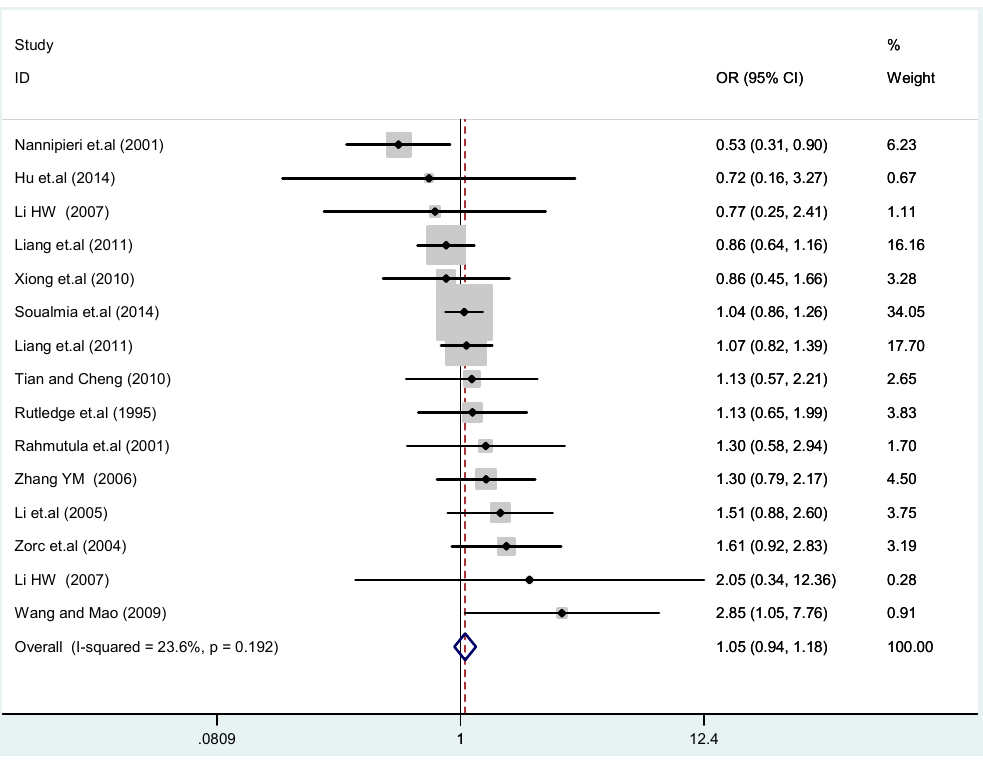
Figure 2. Forest plot of overall population of T2238C additive model (C vs. T).